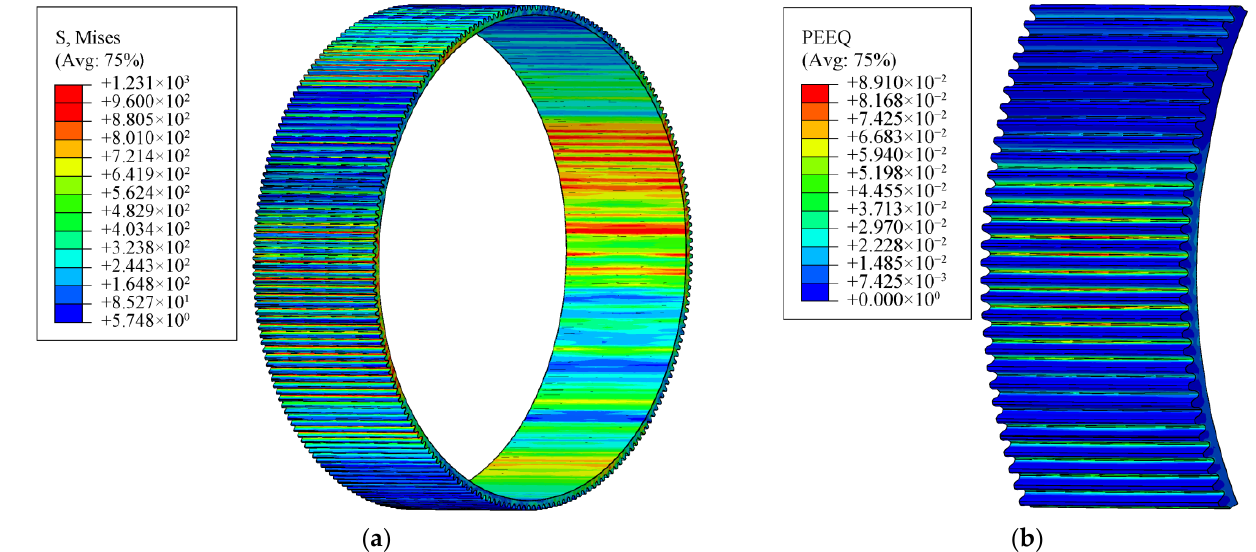
Figure 25. ( a ) Equivalent stress of the flexible wheel in case of overload; ( b ) plastic strain of the flexible wheel in case of overload.